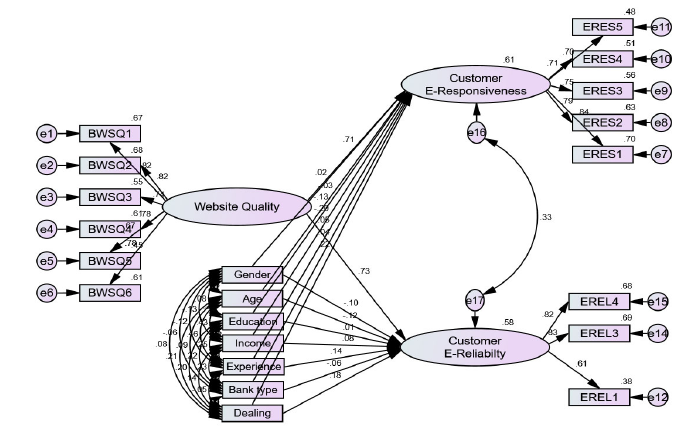
Fig. 1. The results of testing the hypotheses of the